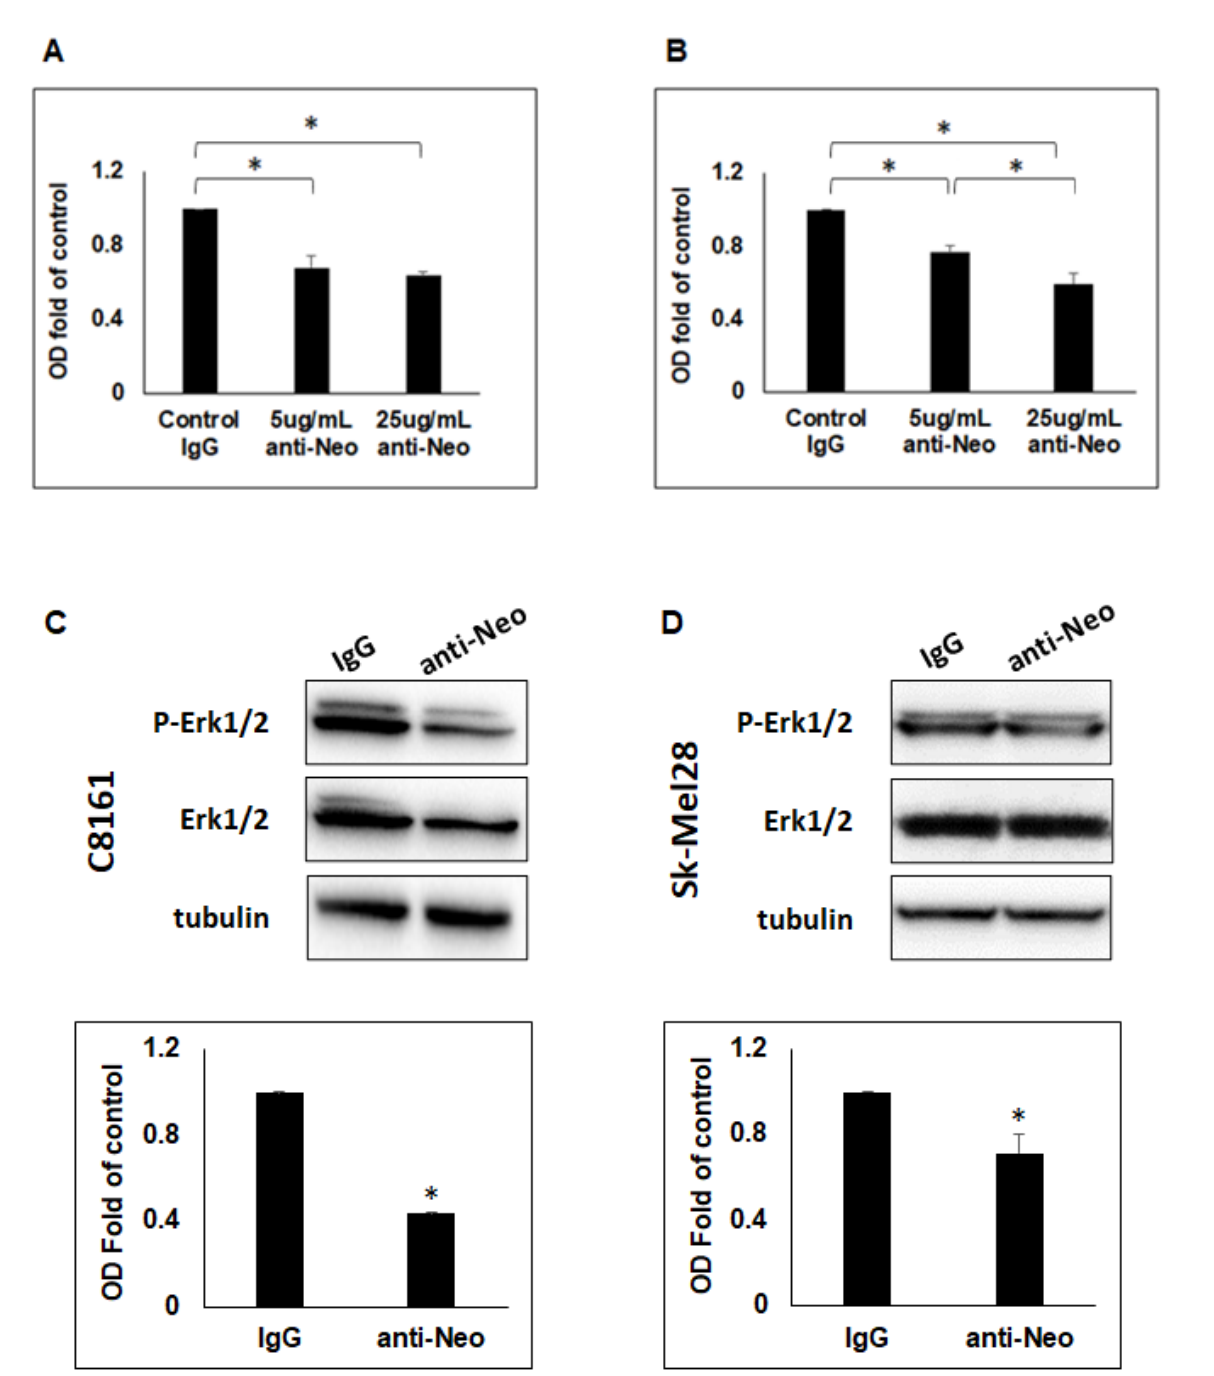
Figure 4. Effect of anti-Neogenin function blocking antibody on migration of aggressive melanoma cells towards a cellular source of Netrin-1 and ERK1/2 activity. Results of cell migration assays for ( A ) C8161 ( n = 3) and ( B ) Sk-Mel28 ( n = 3) aggressive melanoma cells towards Netrin-1-expressing SH-SY5Y cells was significantly reduced after treatment with either 5 µg/mL or 25 µg/mL of anti-Neogenin blocking antibody for both cell lines when compared to control IgG. Migration of Sk-Mel28 was also significantly lower when treated with 25 µg/mL compared to 5 µg/mL of anti-Neogenin blocking antibody (* p < 0.05). Additional WB analysis showed a significant decrease of P-ERK1/2 in ( C ) C8161 ( n = 3) and ( D ) Sk-Mel28 ( n = 3) aggressive melanoma cells treated with 5 µg/mL or 25 µg/mL, respectively, of anti-Neogenin blocking antibody compared to IgG control (* p < 0.05).